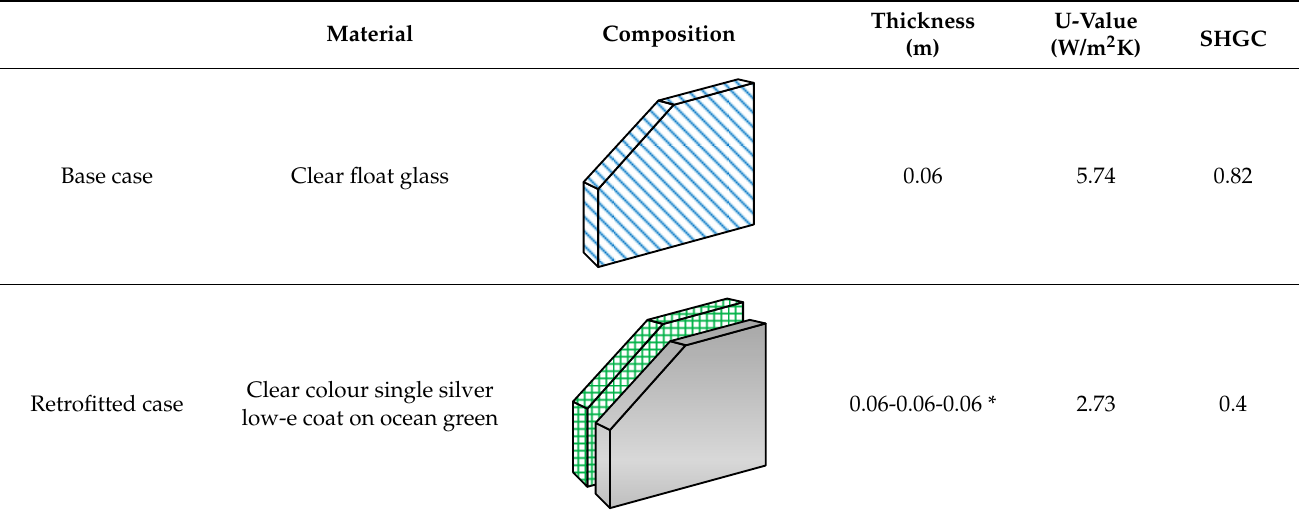
Table 9. Thermal properties of transparent materials employed in the envelope of the case-study building. SHGC: Solar heat gain coefficient.